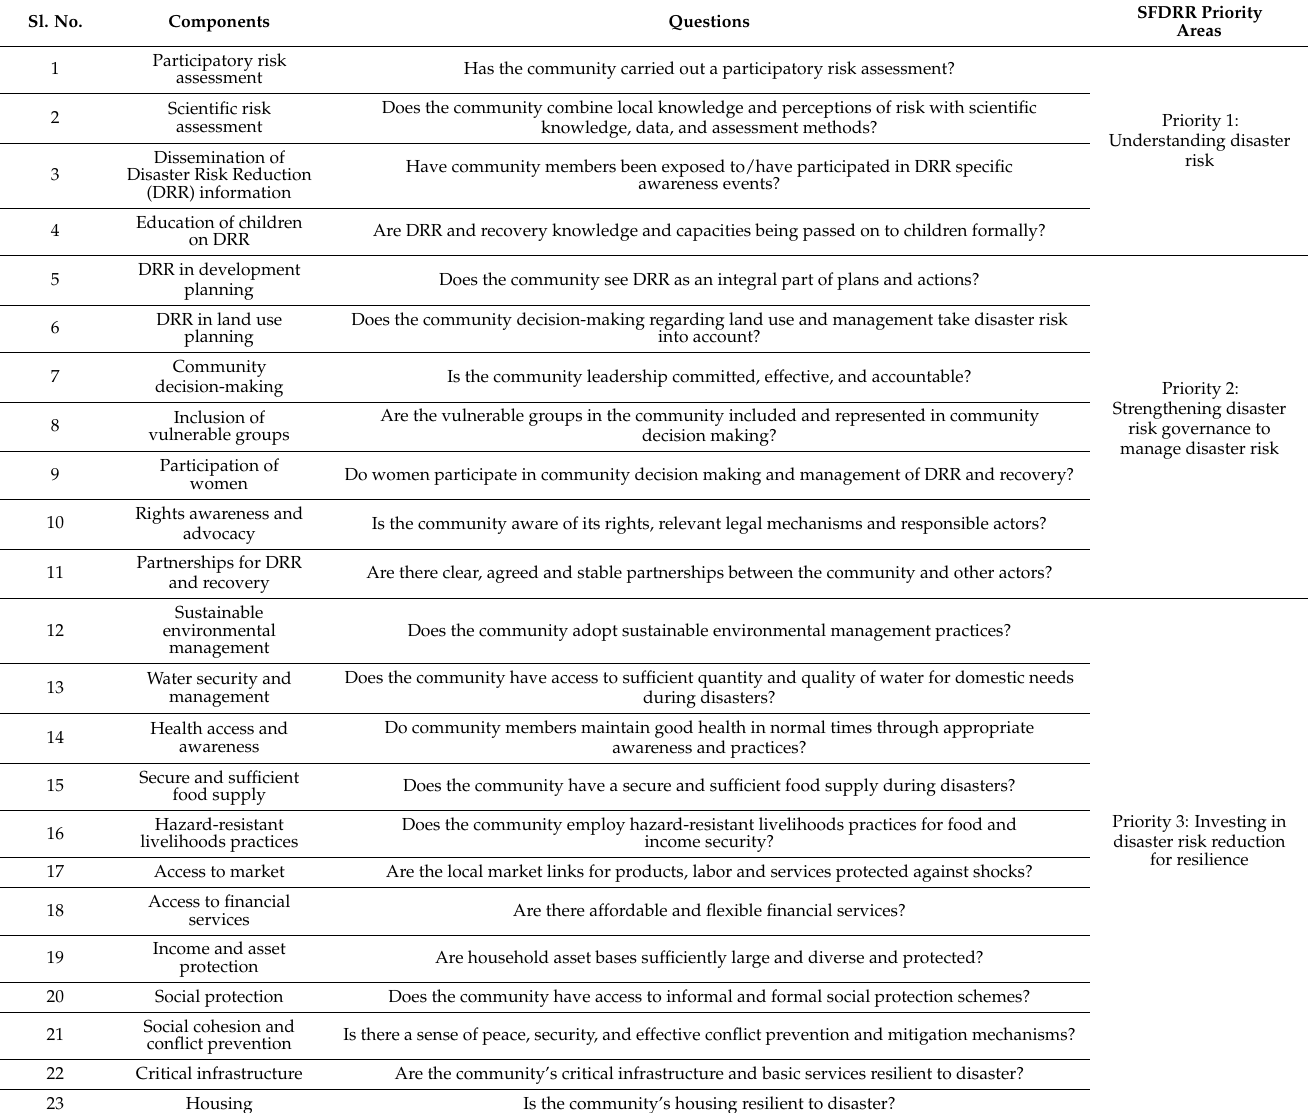
Table 1. ARC-D toolkit resilience components, questions, and measurement scores